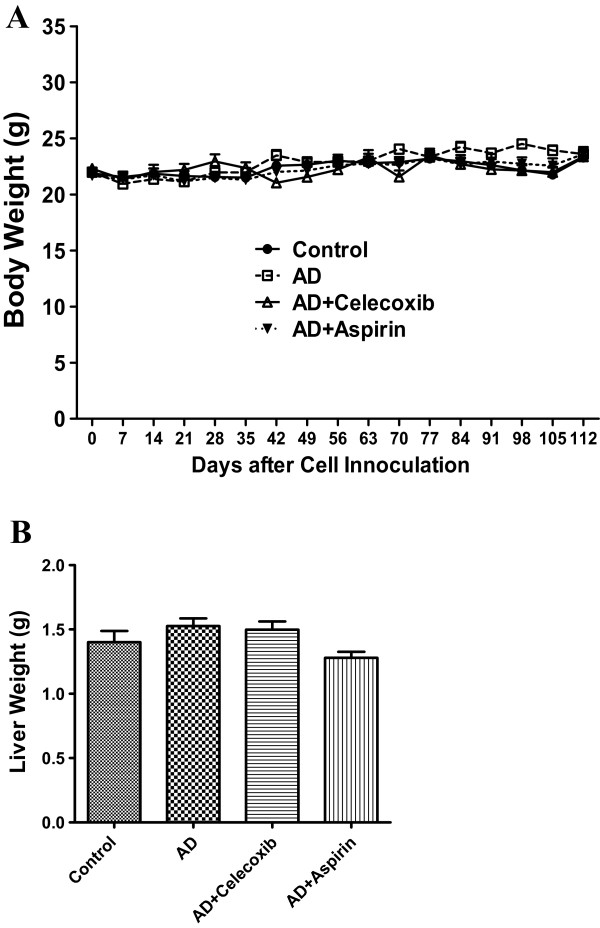
Celexoxib or aspirin treatment had no effect on body weight and liver weight. Mice were inoculated with MCF-7aro cells and treated with celecoxib, aspirin and androstenedione. Their body weight (A) was monitored from the second week after inoculation and liver weight (B) was measured at the end of experiment. Groups labeled as AD, AD+celecoxib, and AD+aspirin are the mice treated with androstenedione, androstenedione and celecoxib, and androstenedione and aspirin, respectively. Values are means ± SEMs, n=6 to 8. The data was analyzed by One-way ANOVA, followed by Tukey’s Multiple Comparison test when P<0.05.